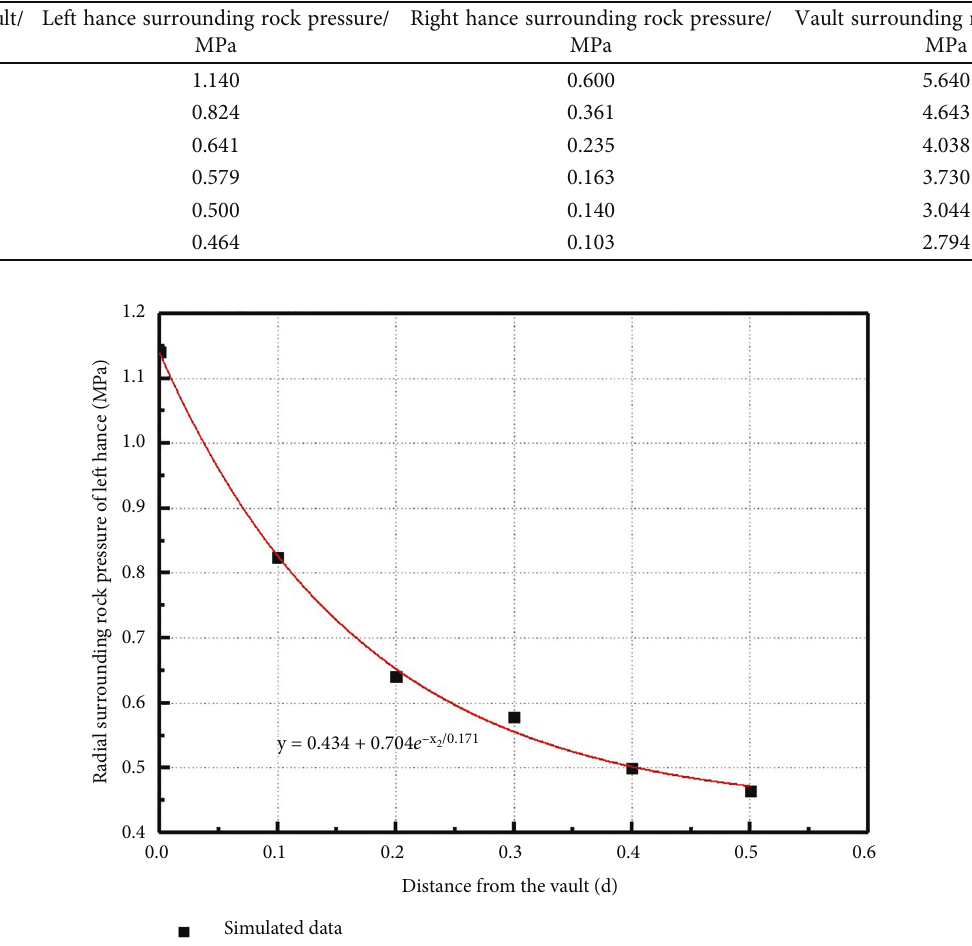
Table 3: Weak interlayer with di ff erent locations corresponding to the surrounding rock pressure values of left hance and right hance and the vault.